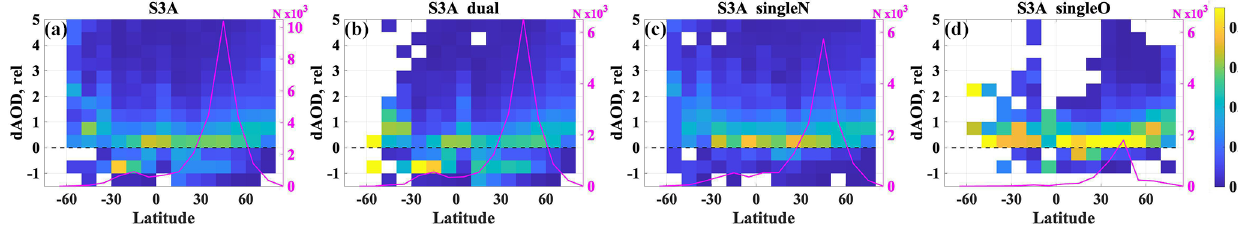
Figure 9. For S3A, density scatter plot for the latitude (in degrees) dependence of the syAOD relative offset for all (a) , dual (b) , and singleN (c) groups of pixels. Colour indicates the fraction of the points with a corresponding dAOD,rel interval from the total number of points within the latitude bin. The magenta line shows the total number of matchups in the corresponding latitude bin.